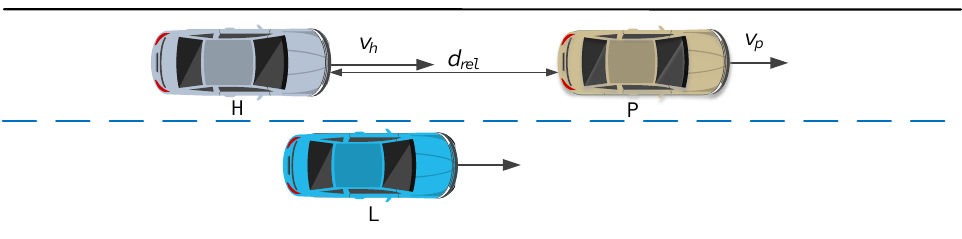
Figure 9. Insufficient relative distance.